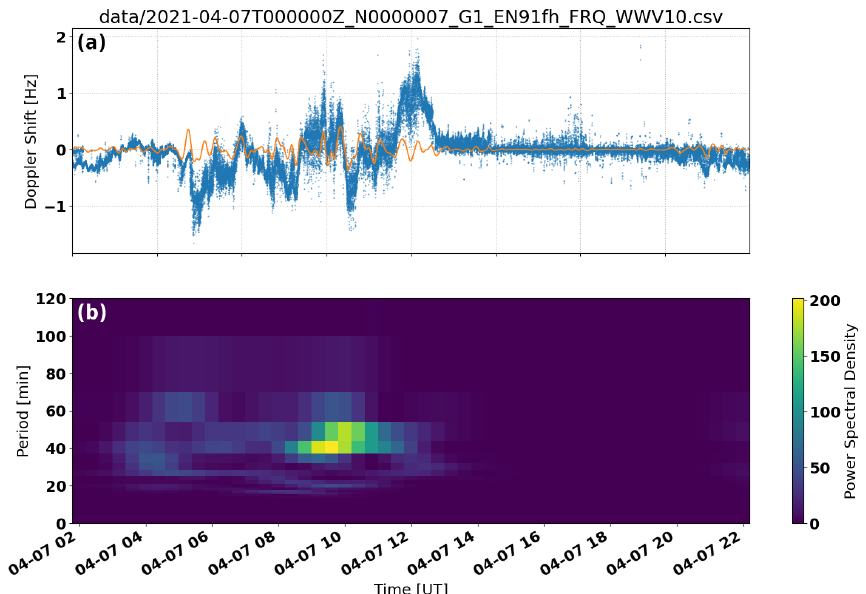
Figure 8. Observations of the 10MHz WWV signal (Ft. Collins, CO) received by a Grape receiver located near Cleveland, OH, on 7 April 2021 from 02:00–22:00UT. (a) Time series of received 10MHz Doppler shifts. Blue dots show raw observations, and the orange trace shows data filtered with a 15–60min digital bandpass Butterworth filter. (b) Spectrogram showing power spectral density (PSD) of the filtered data from the top panel. The oscillations and enhanced PSD in the 15–60min band observed between ∼ 03:30 and ∼ 12:00UT are consistent with signatures of medium-scale traveling ionospheric